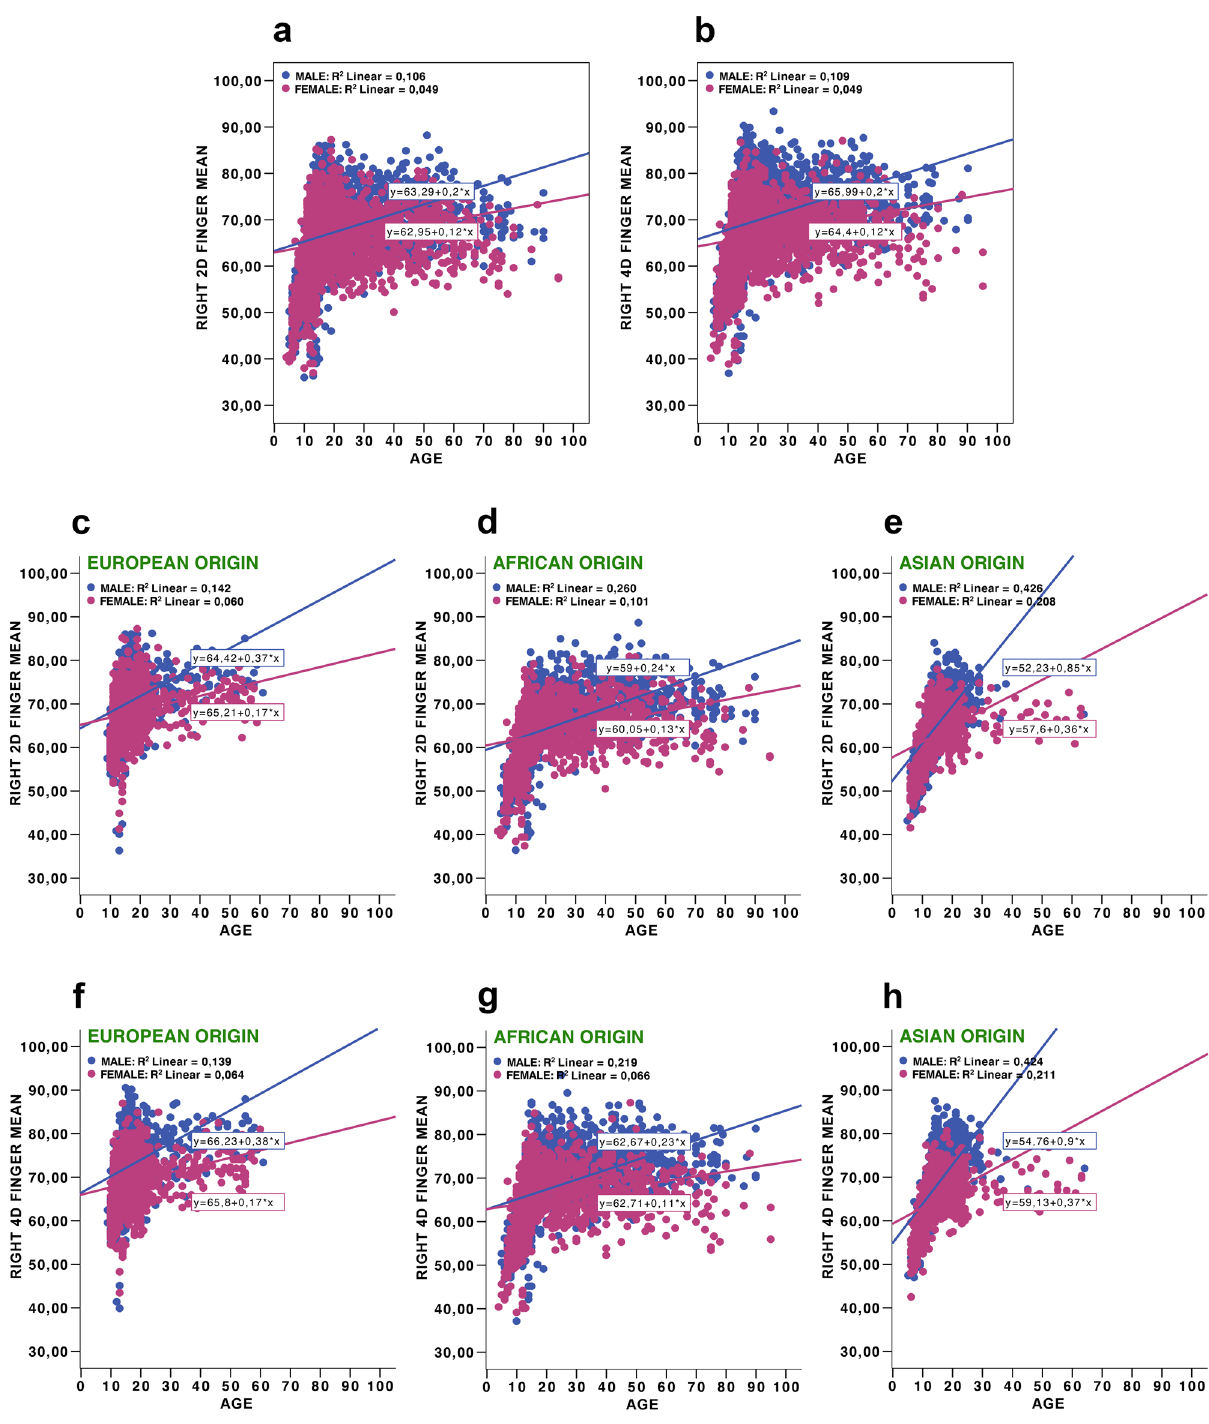
Figure 2. Right 2D and 4D finger means to age: right 2D finger means to age in total sample ( a ), right 4D finger means to age in total sample ( b ), right 2D finger means to age in three populations (European origin ( c ), African origin ( d ), Asian origin ( e )), right 4D finger means to age in three populations (European origin ( f ), African origin ( g ), Asian origin ( h